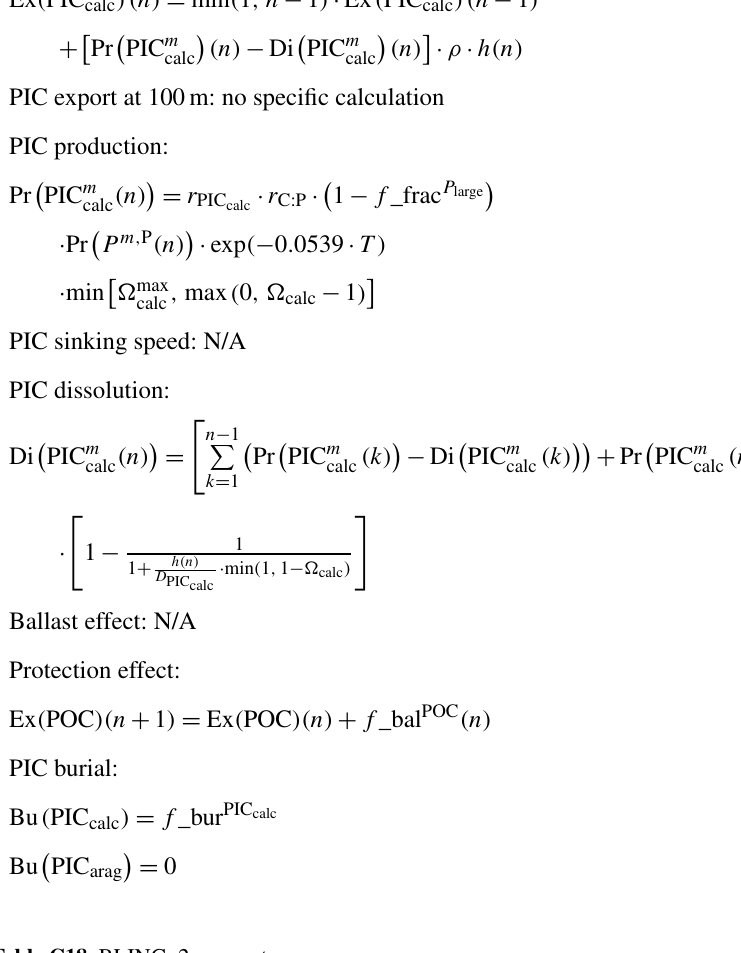
Table C18. BLINGv2